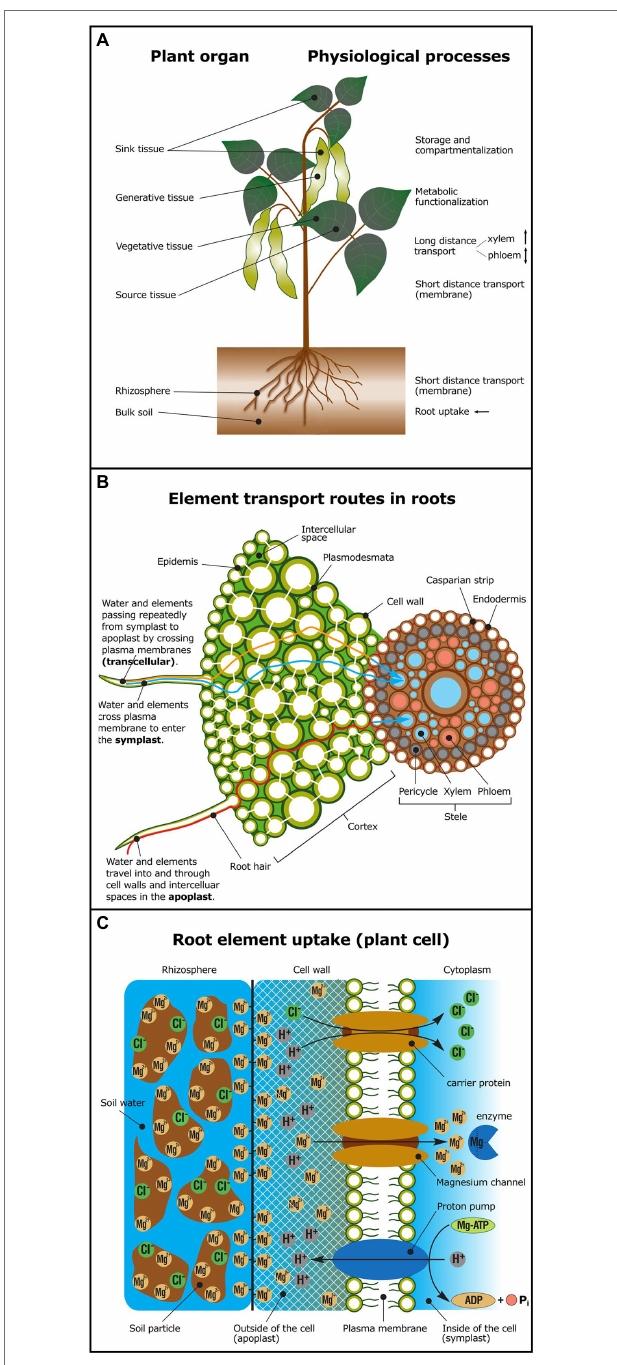
FIGURE 1 | Overview of physiological processes potentially causing isotope fractionation. (A) In shoots, isotope fractionation may occur during short distance transport across membranes, during long-distance transport in xylem (unidirectional transport) or in the phloem (bidirectional transport), due to metabolic functionalization (e.g., enzyme activation, ligand exchange), element storage or compartmentalization. Major physiological processes in roots are nutrient uptake and short distance transport across membranes. Elements are taken up from the rhizosphere and translocated via the xylem to sink tissue (young leaves or generative tissue, such as fruits, grains, or pods). Elements may also be re-translocated via the phloem from source tissue (e.g., old leaves)